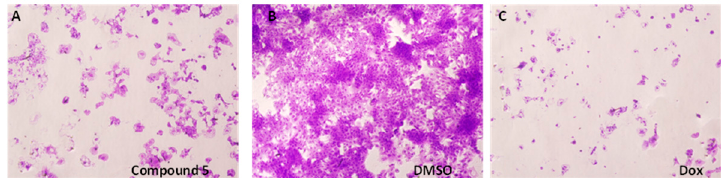
Figure 3. Morphological changes of ( A ) Hep3B cells after the 48 h treatment with compound 5 (at 1.8